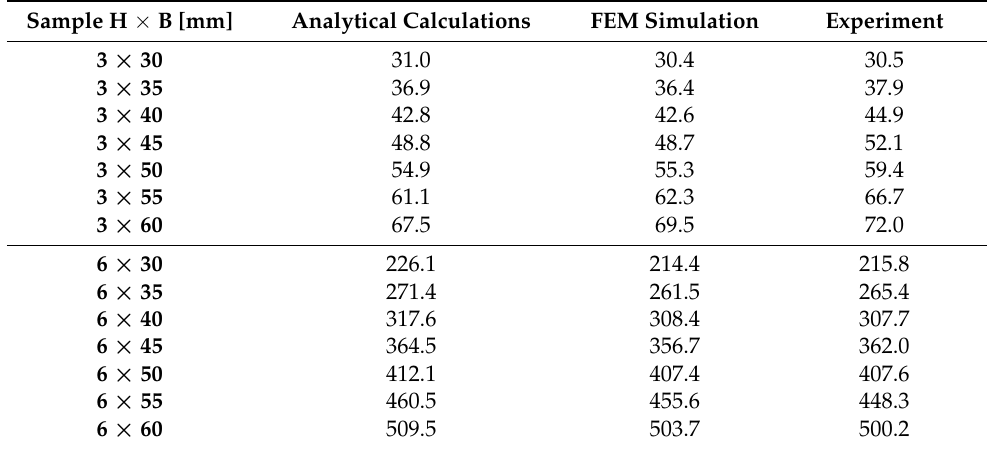
Table 5. Summary of the results of calculating the torsional moment [Nm] of unexpanded test sets using analytical, numerical and experimental methods.